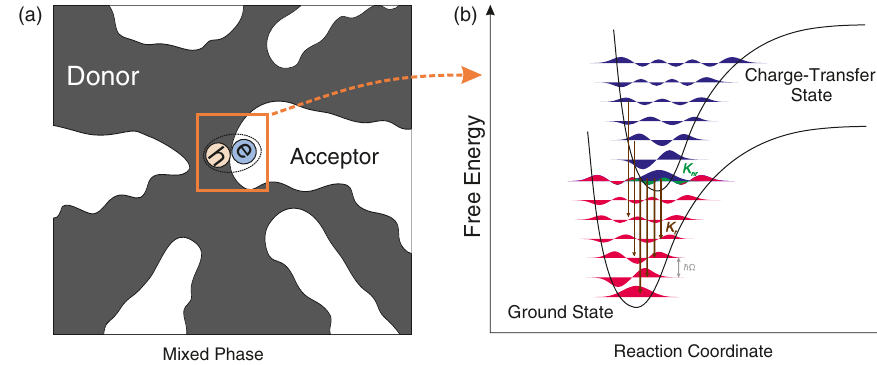
FIG. 1. Recombination mechanism in organic photovoltaics. (a) Schematic illustrating an electron and hole occupying an interfacial charge-transfer state in a bulk-heterojunction system. (b) The potential energies of the ground state and charge-transfer state at the donor- acceptor interface as a function of the reaction coordinate. The quantized vibrational modes are shown as the colored waves: red for modes of the electronic ground state and blue for modes of the charge-transfer state. The green overlap between the lowest vibrational state of the charge-transfer state (which defines the energy of the apparent charge-transfer state) and a vibrationally excited ground state indicates the nonradiative recombination pathway. The arrows depict possible radiative decay pathways. While we indicate here some radiative decay from higher-energy vibronic modes, most decay originates from the lowest vibronic state of the charge-transfer